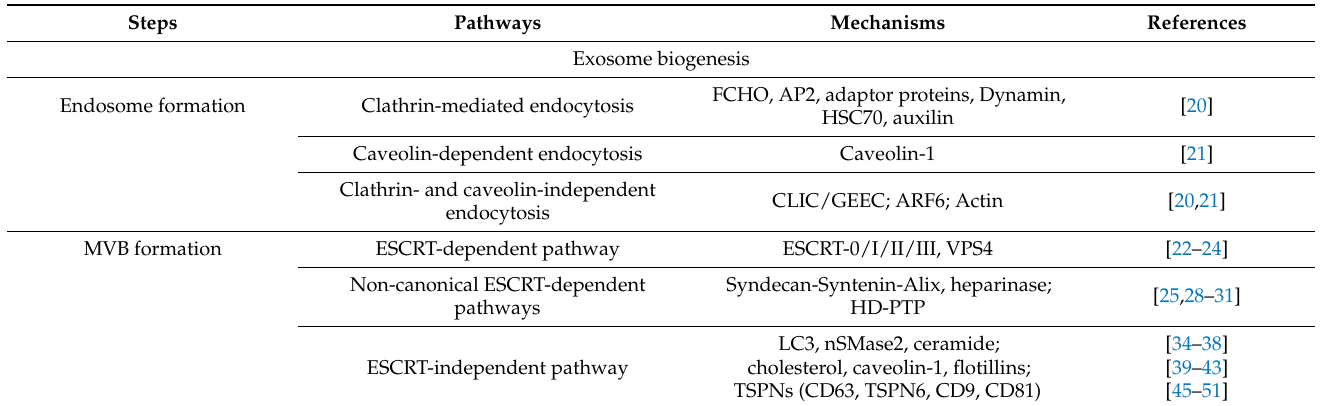
Table 1. Steps in exosome biogenesis and associated